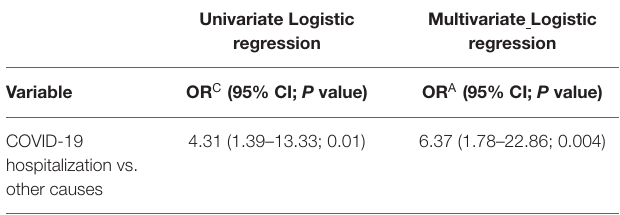
TABLE 3 | Univariate and Multivariate Logistic regression results to assess whether CD patients diagnosed with COVID-19 on hospital admission have a higher chance of in-hospital